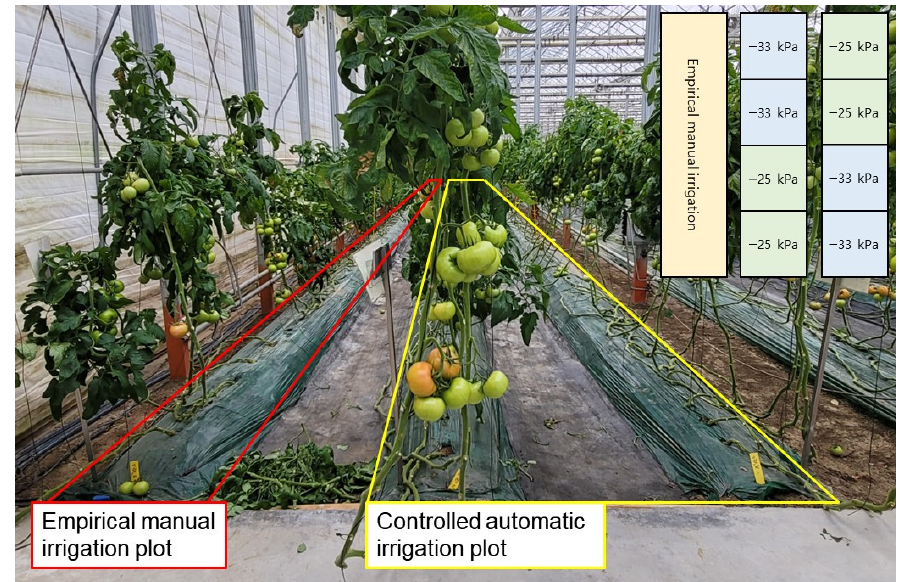
Figure 8. The picture of the experimental field on a tomato farm in the first cropping season.